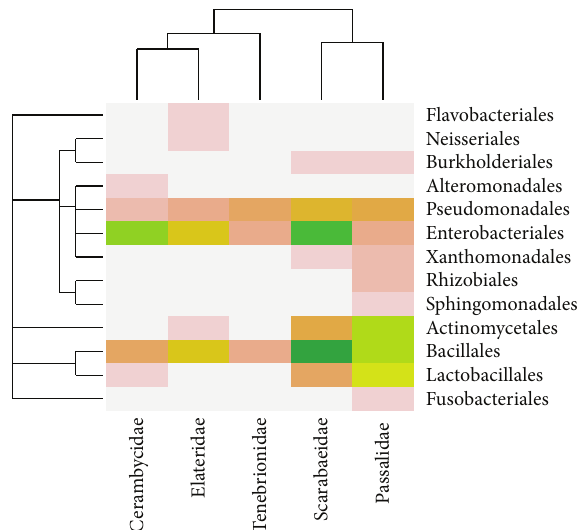
Figure 2: Heatmap of the abundance distribution of bacterial communities associated with the guts of five wood-feeding families of Coleoptera. The taxonomic relationship of the bacterial genera is shown in the rows, while the clustering of the coleopteran families, determined by their composition similarities, is shown in the columns. Higher intensities of the color reveal higher abundances of the